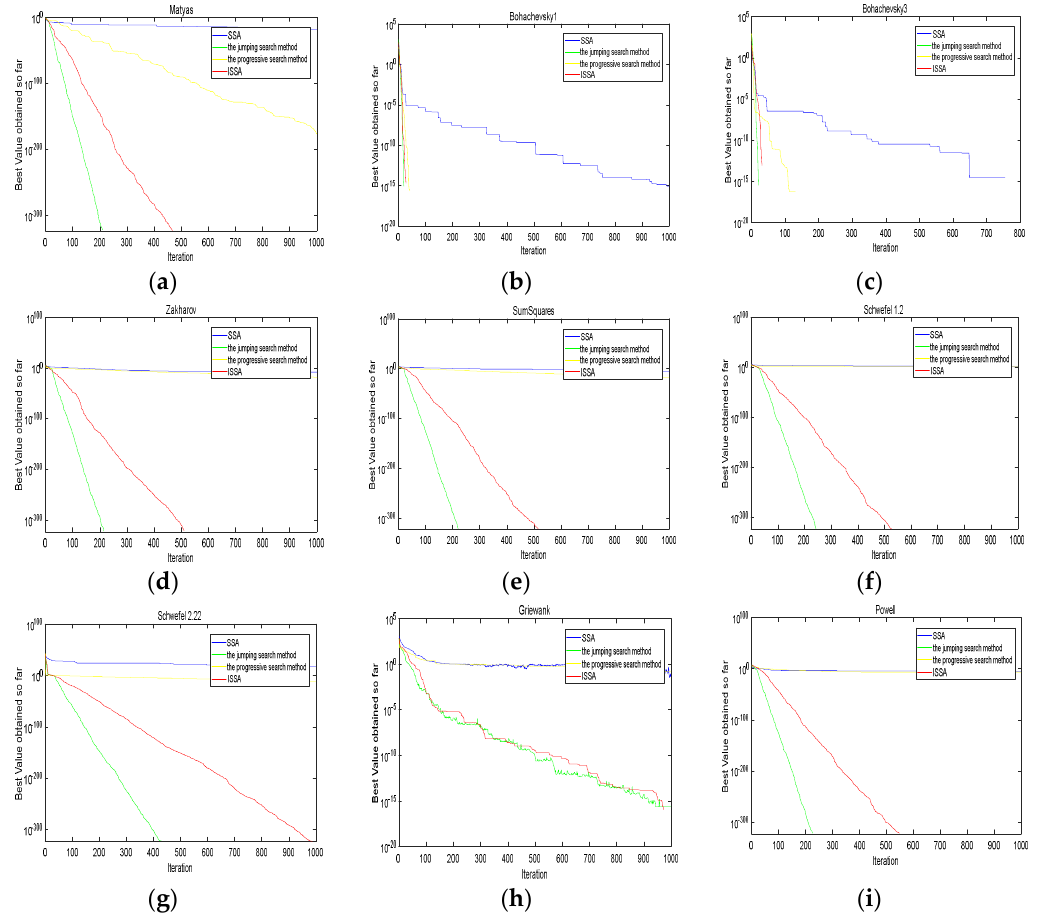
Figure 4. Convergence curves of the proposed methods and SSA.